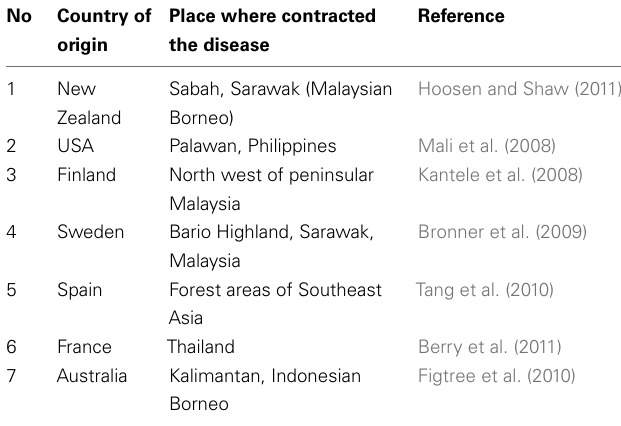
Table 1 | Distribution of knowlesi malaria cases acquired